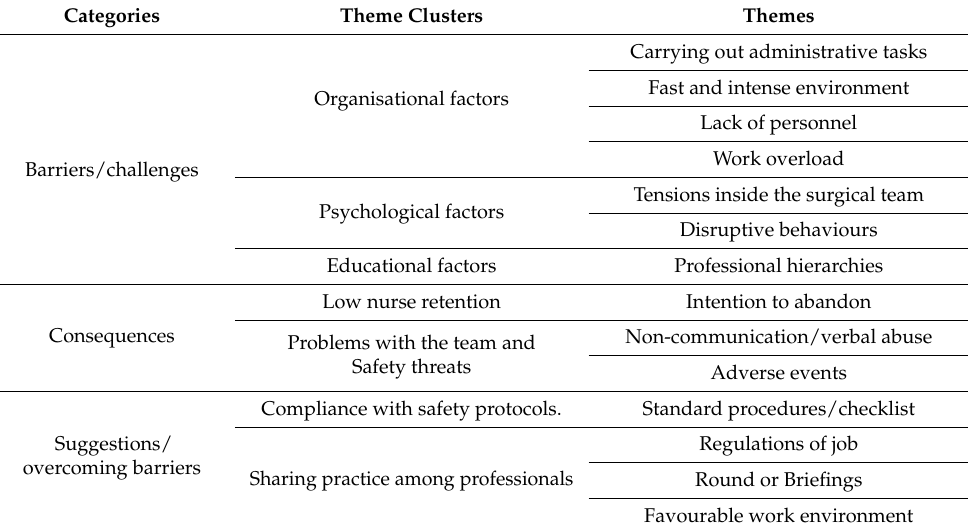
Table 3. Categories, theme clusters, and